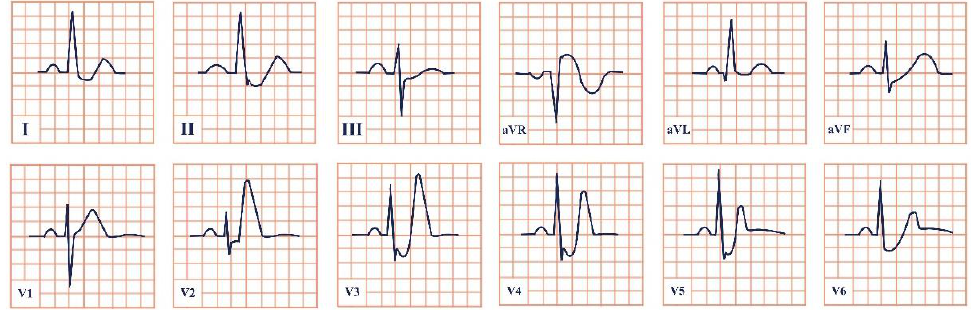
Figure 2. Electrocardiogram aspect in De Winter syndrome.